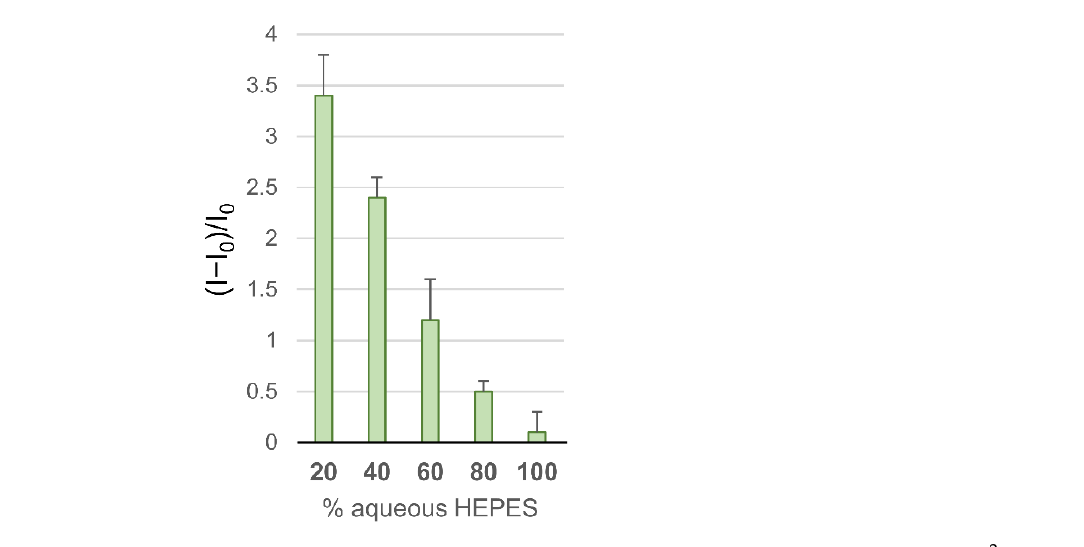
Figure 3. Fluorescence emission increase upon addition of 1 equivalent of Cd 2+ to a solution of L in different ACN—aqueous HEPES buffer v/v solvent mixtures. [ L ] = 3.2 × 10 − 6 mol dm − 3 ; [HEPES] = 1.0 × 10 − 3 mol dm − 3 ; pH 7.4; λ ex = 305 nm. λ em = 390 nm (100% aqueous HEPES), 394 nm (80% aqueous HEPES), 397 nm (60% aqueous HEPES), 398 nm (40% aqueous HEPES), and 398 nm (20% aqueous HEPES).